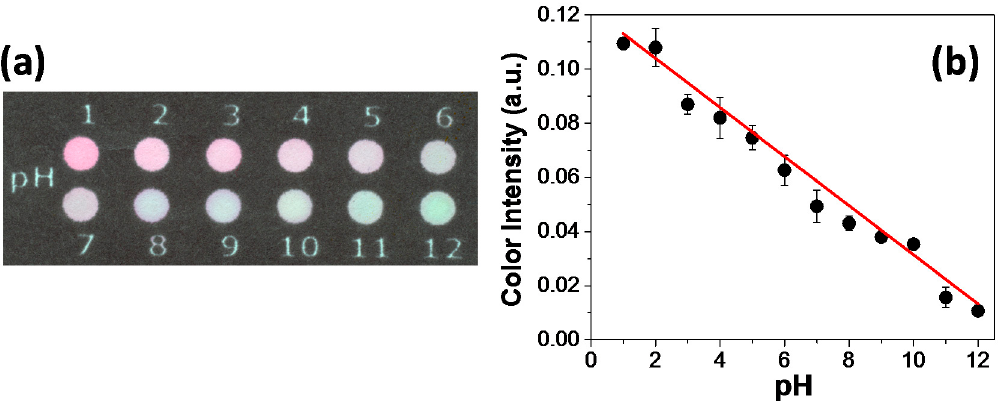
Figure 2. Presentation of ( a ) an optical micrograph showing the color changes on printed zones and ( b ) color intensity analysis over different pH values. In (a), microzones were first spotted with 5 µ L of the natural indicator. Then, 5 µ L of different solutions prepared at pH range from 1 to 12 were added on microzones prior to image capture. The labels depicted in (a) indicate the used microzones for each pH value.